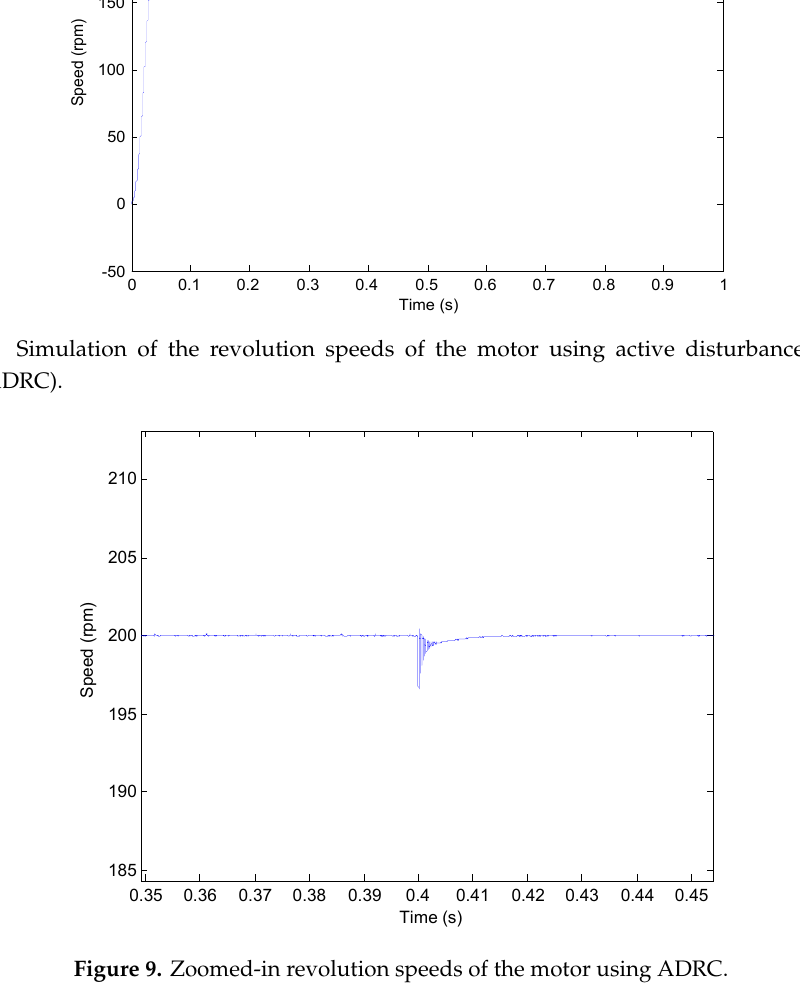
Figure 10. Impact acceleration test results for the arm. The unit being tested is fixed on the arm. The axial direction of the unit being tested points to the normal direction of the arm, and the radial direction of the unit being tested points to the tangential direction of the arm. So, the tangential acceleration of the arm is the radial acceleration of